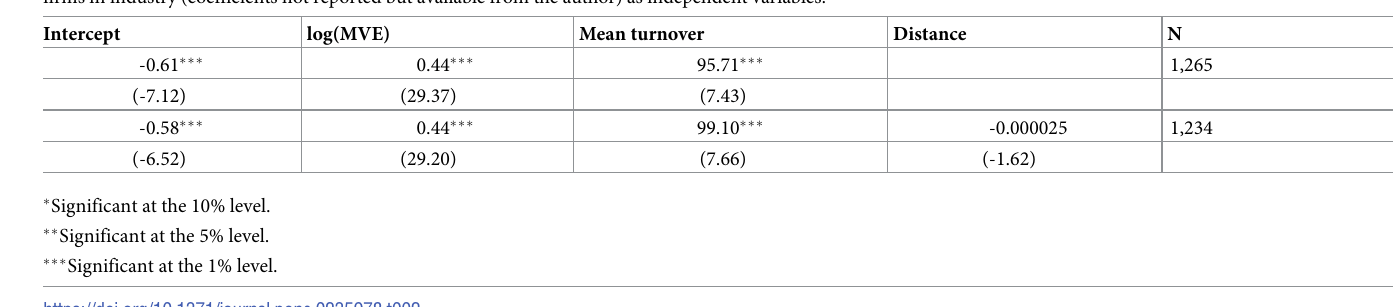
Table 2. Which firms does WSJ write about? Coefficients and z -statistics (in parentheses) from a Poisson regression with a negative binomial model form with the num- ber of WSJ articles published about each firm as the dependent variable and log of market value of equity (at end of December 1969 or first day of trading, whichever is later), mean daily stock turnover of each firm, distance of firm headquarters from WSJ headquarters and the number of WSJ articles on 2-digit SIC industry/number of firms in industry (coefficients not reported but available from the author) as independent